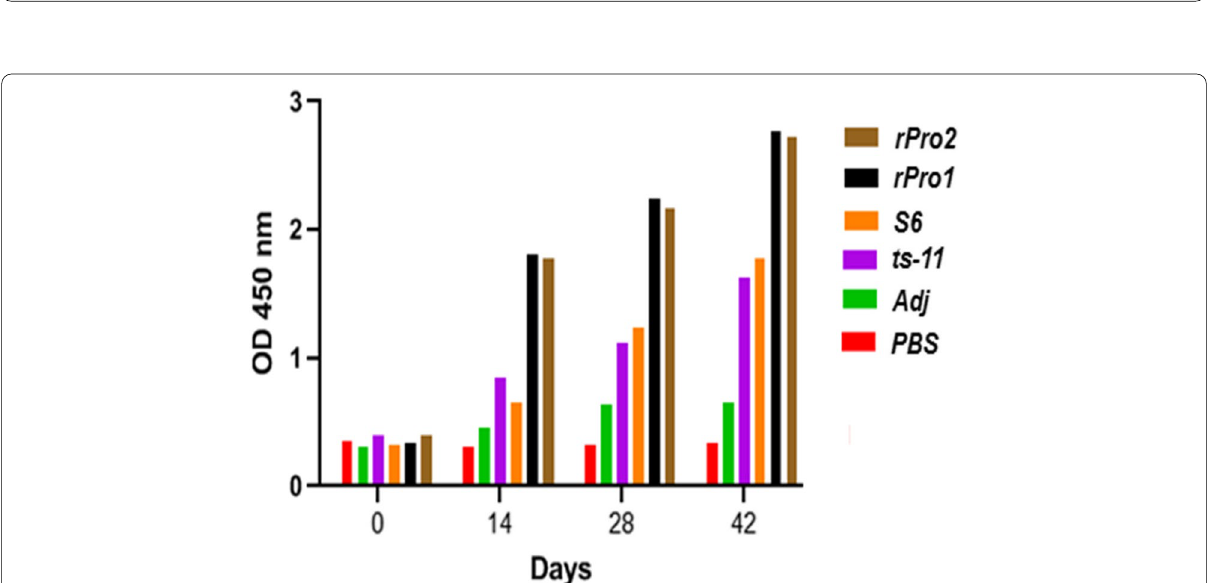
Fig. 4 Dynamic changes in the serum antibody levels of immunized chickens. The serum antibody levels were measured by indirect ELISA. The serum was collected at four time points. Day 0, for determination of the preimmunization titer. Numbers represent the mean optical density at 450 nm (OD 450) of serum samples collected at 0, 14, 28, and 42 days after immunization in each group. Chickens were immunized with rPvpA-pMGA (50μg and 20μg), ts-11 vaccine strain, S6 strain, adjuvant, and PBS groups. rPvpA-pMGA (rPro1): 50μg, rPvpA-pMGA (rPro2):